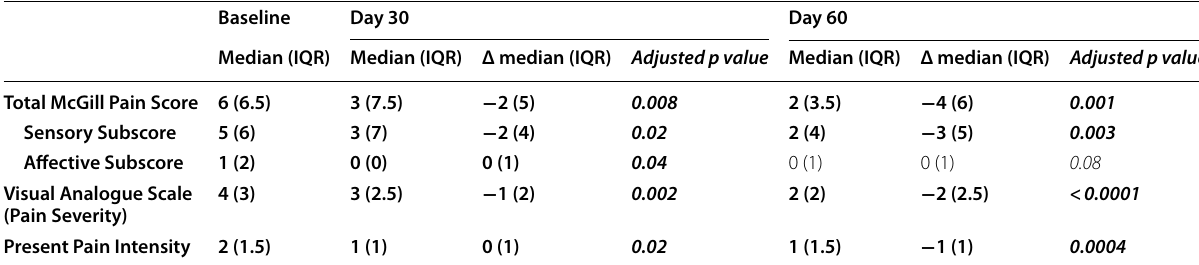
Table 2 Short‑Form McGill Pain Scores